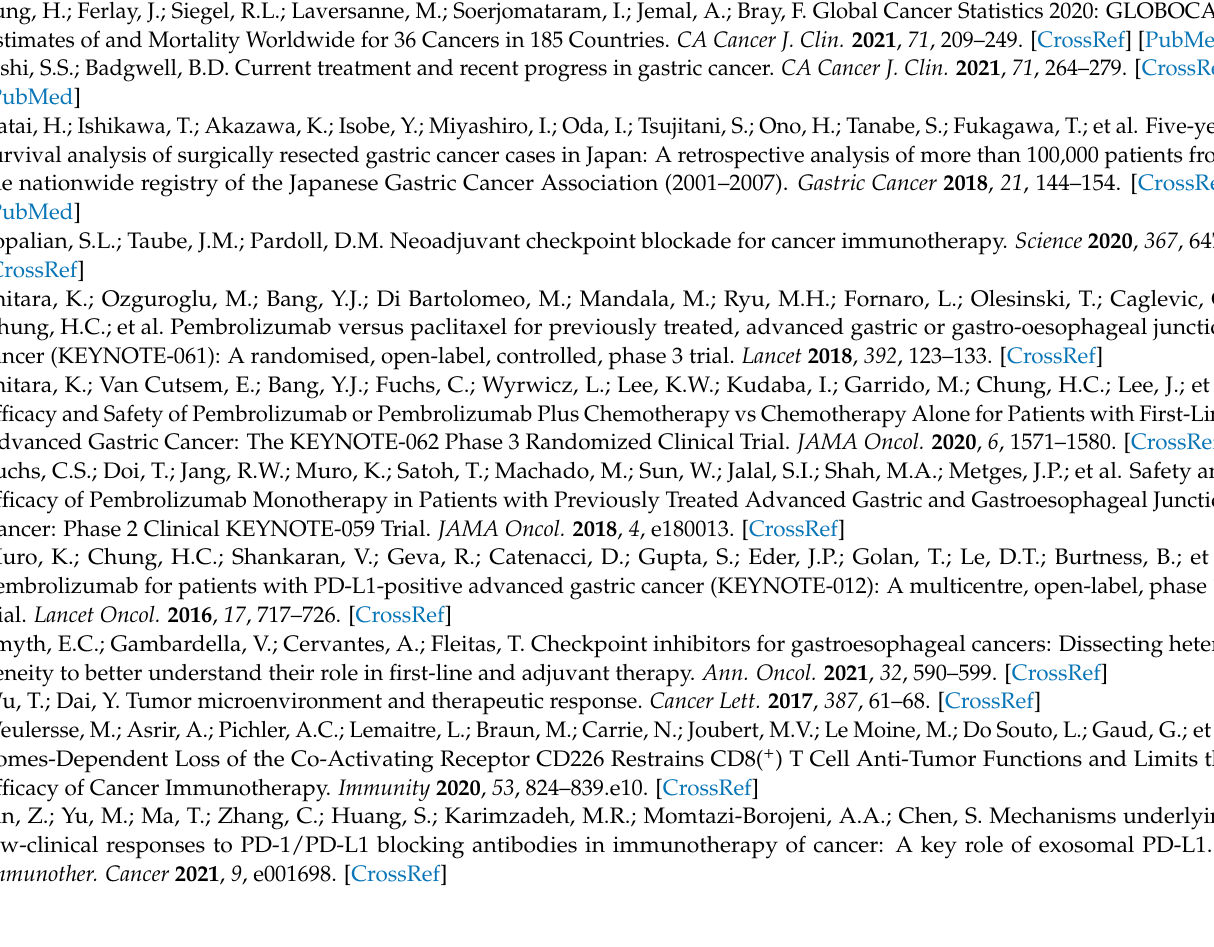
Table S4: Drug candidates with potential therapeutic effect for the low-risk group or the high-risk group, Table S5: Drug candidates and corresponding biomarkers for HP+ GC patients, Table S6: Correlation between 15902 genes with IRSHG using Pearson correlation analysis, Table S7: The result of CMap